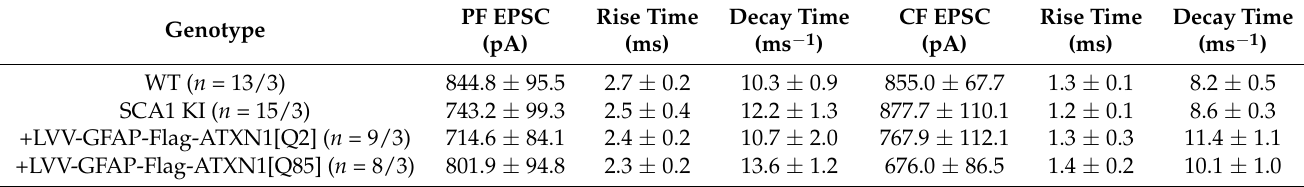
Table 2. AMPA receptor-mediated EPSCs in PC of 12-week-old mice. Kinetics of PF EPSCs and CF EPSCs (10–90% rise time and decay time constant) and their amplitudes are shown. t -test did not show any significant difference. n —number of cells/number of animals, p >